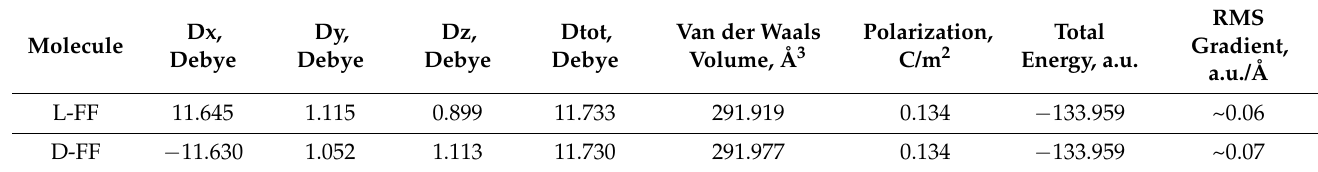
Table 2. The dipole moments and some other structural parameters of individual L-FF and D-FF molecules calculated by PM3 method.